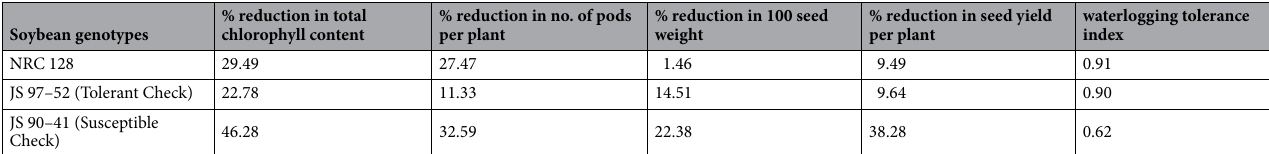
Table 7. Evaluation of NRC 128 for waterlogging tolerance at reproductive (R1) stage under controlled